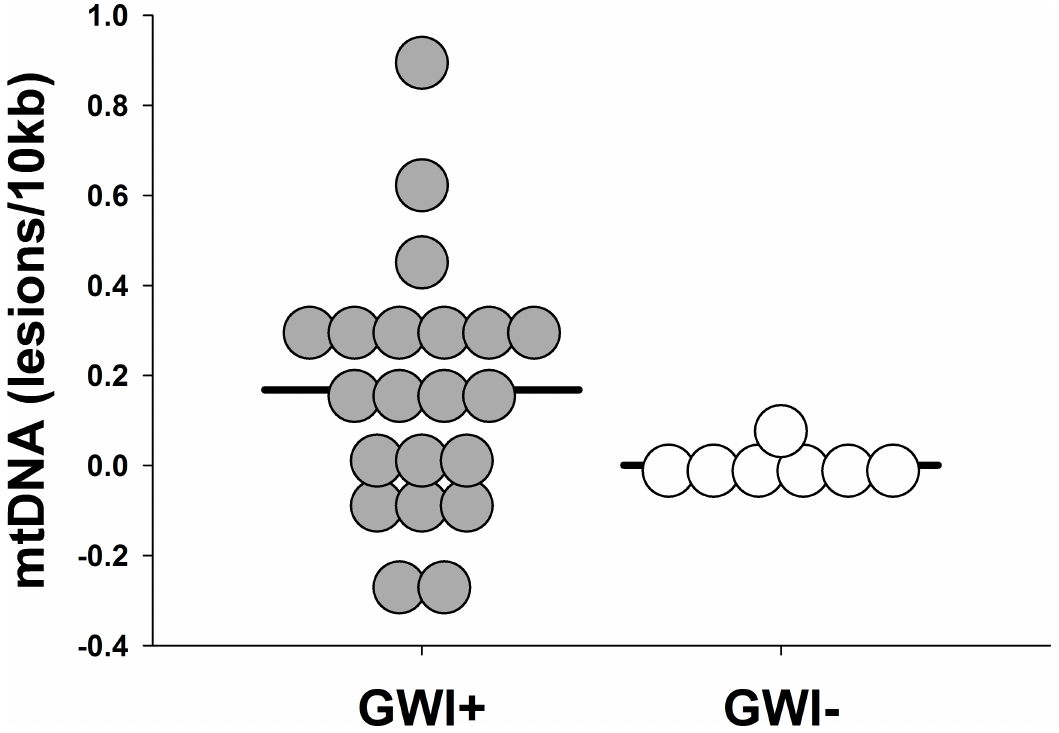
Fig 1. Mitochondrial DNA damage identified by QPCR analysis of blood for cases with (n = 21, GWI+) and without (n = 7, GWI-) Gulf War Illness. Dot density plot data represent the number of excess lesionsfound per 10 kb of DNA from mtDNA genomesin GWI+ cases as comparedto controls (GWI-). Greater lesions(0.17 lesions/10kb) were observed amongcases with GWI+ relativeto controls ( p = 0.015, d =